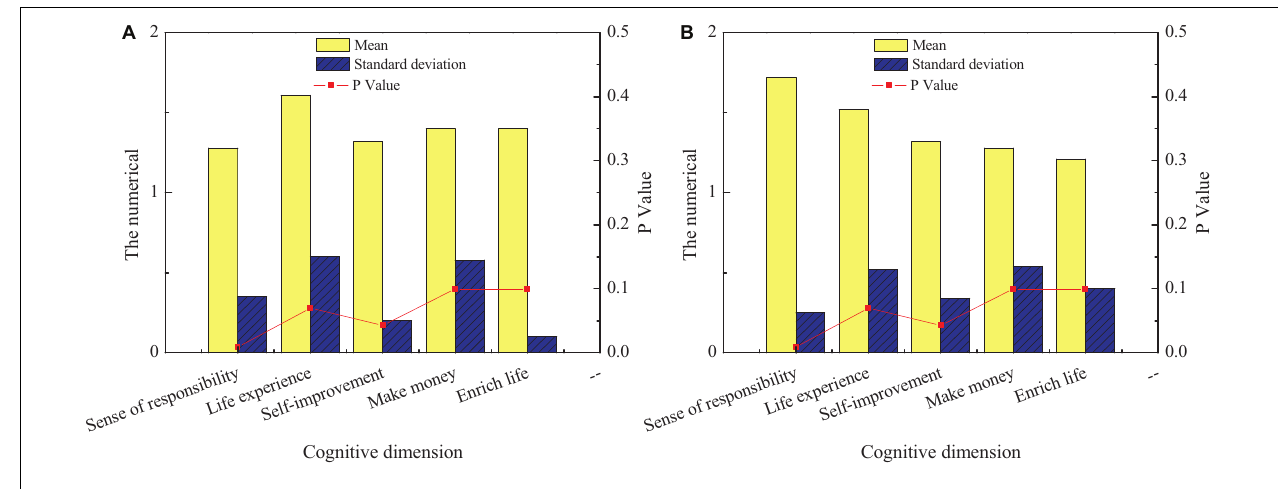
FIGURE 8 | Comparison of entrepreneurial emotion among students of different genders: (A) men and (B) women.